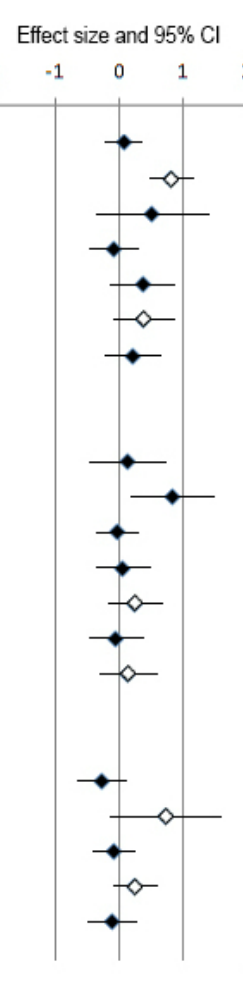
Figure 2. Forest plot of effect sizes for behavior change, downstream, and mediator